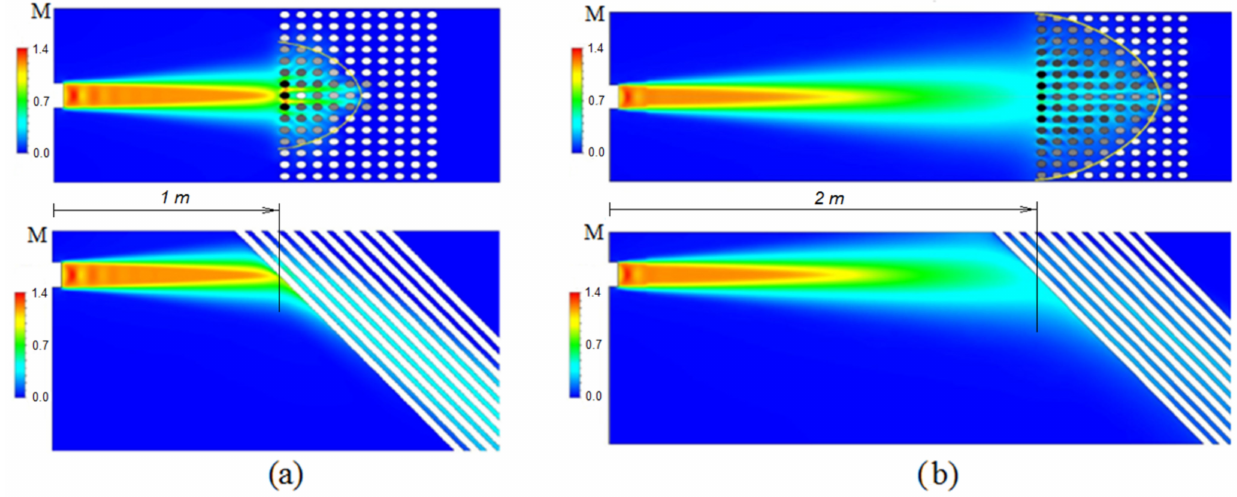
Figure 10. Blowing of the tube package by an air jet with pressure P 0 = 0.235 MPa. ( a ) Case 4; and ( b ) case 8. Upper—XOY plane, lower—XOZ